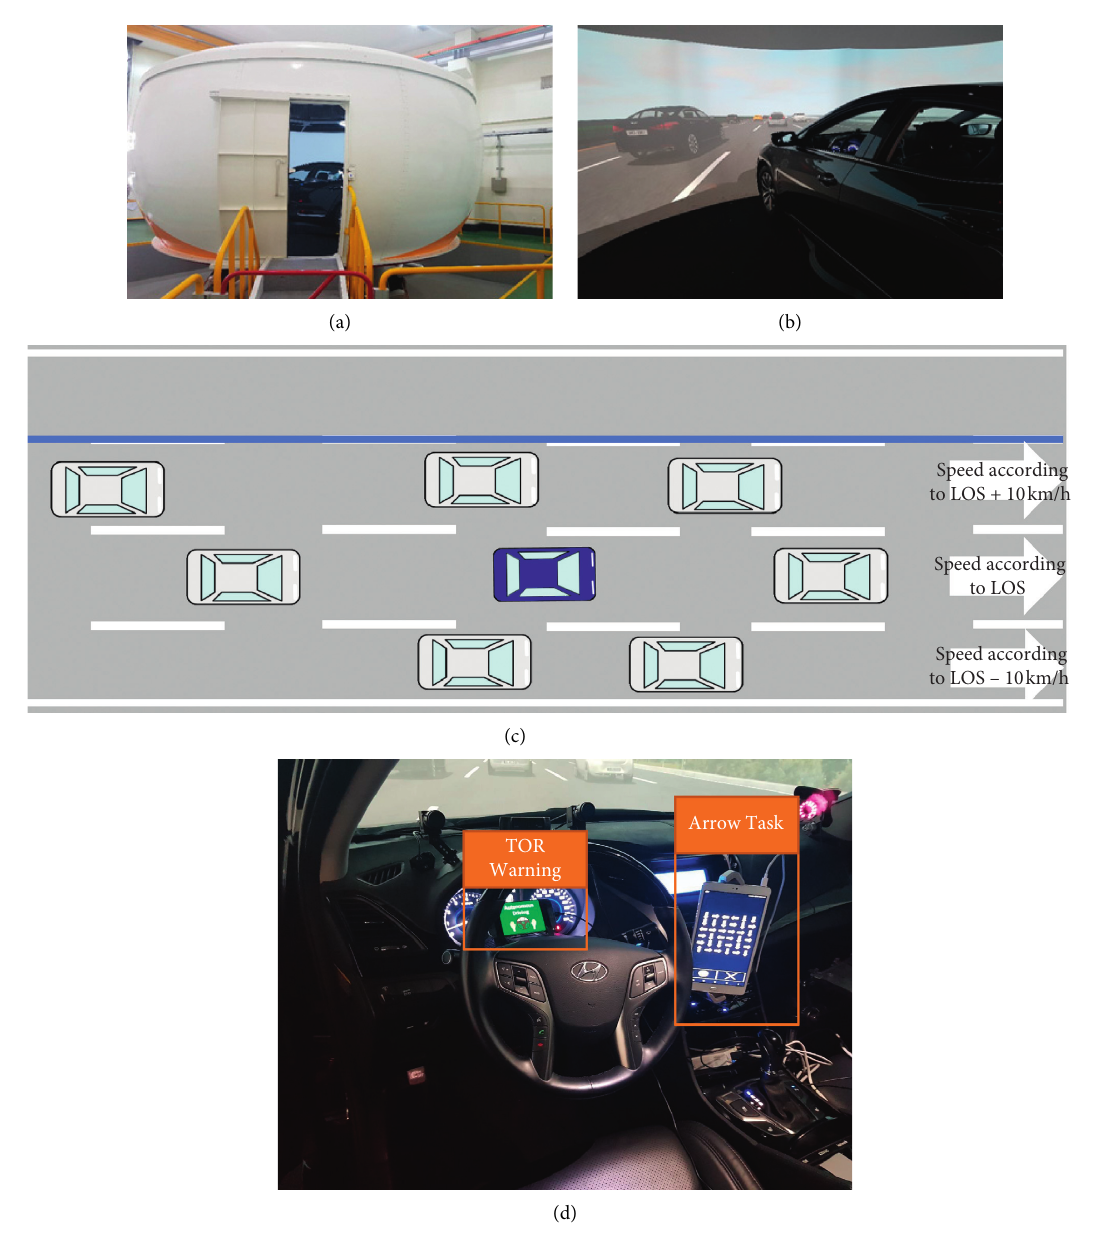
Figure 1: Exterior and interior settings of the driving simulator. (a) Exterior of the driving simulator. (b) Participant’s view inside the driving simulator. (c) Lane configuration in SCANER. (d) Visual warning and NDRT devices. Table 3: Specifications of driving